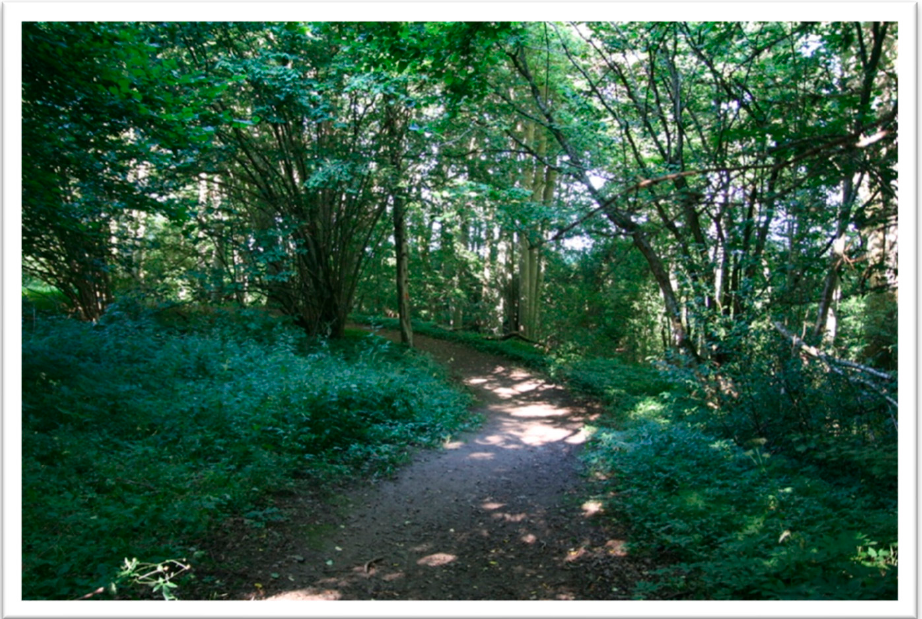
Figure 3. The lake Finjasjön can be glanced between the trees from a trail in Hovdala. [Photo: Hanna Anundi].